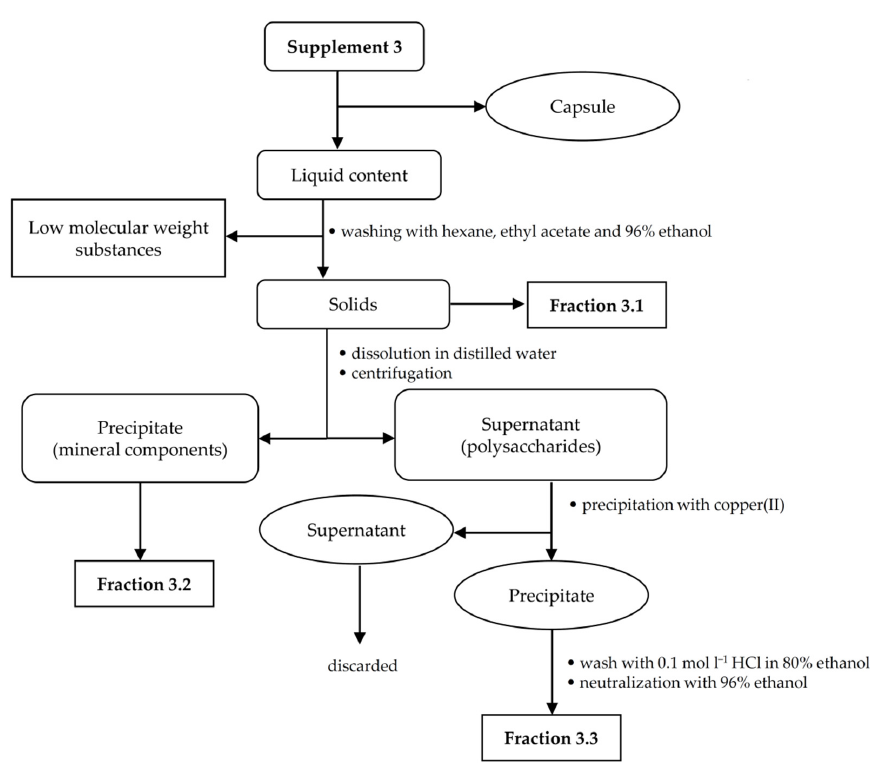
Figure 3. Isolation scheme for supplement 3.